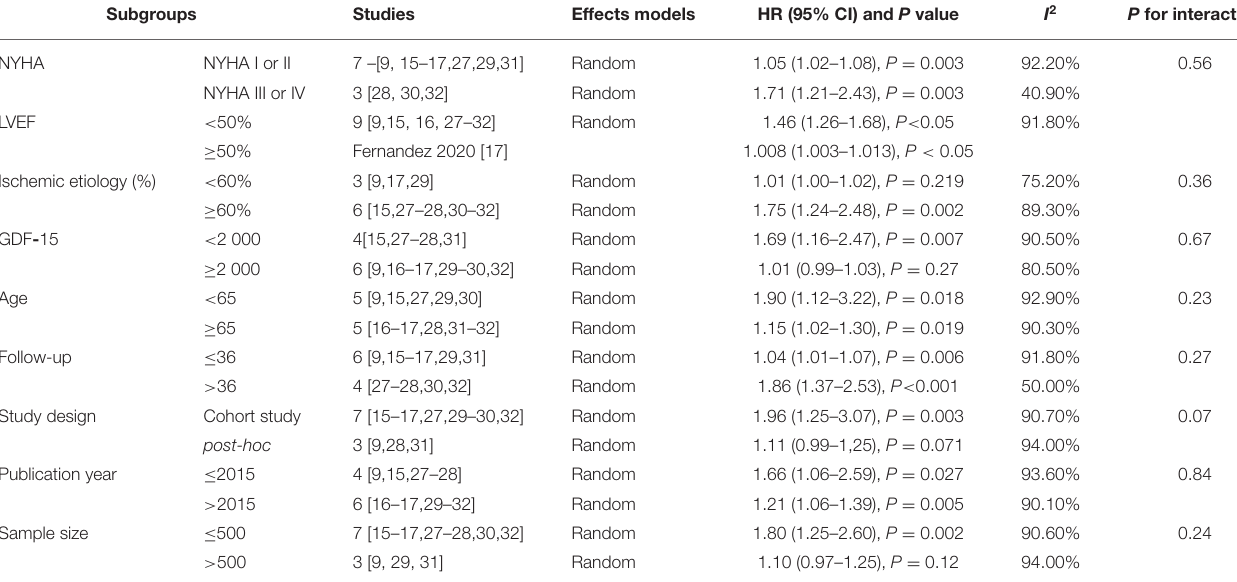
TABLE 3 | Pooled hazard ratios of all-cause mortality in